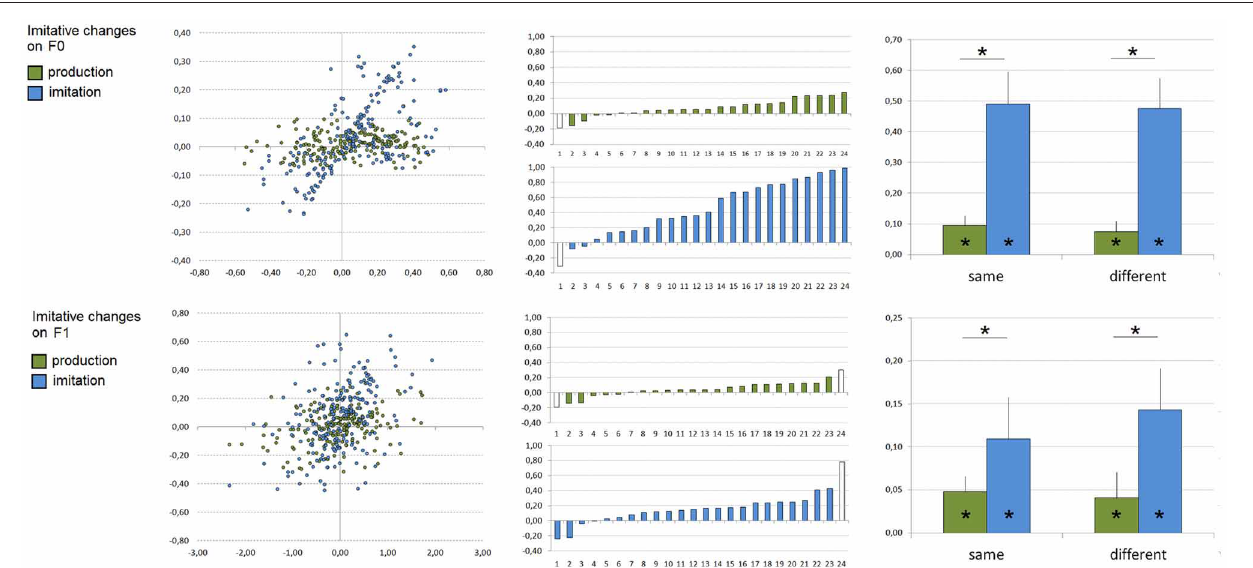
FIGURE 2 | Imitative changes observed during vowel production (in green) and imitation (in blue) on F 0 (top) and F 1 (bottom) values. Left: All correlation-points based on 6480 utterances related to participants’ imitative changes during the presentation of acoustic targets compared to their baseline productions ( X -axis: acoustic target minus subject’s production during the presentation of visual targets, Y -axis: subjects’ production during the presentation of acoustic targets minus subject’s production during the presentation of visual targets; all values